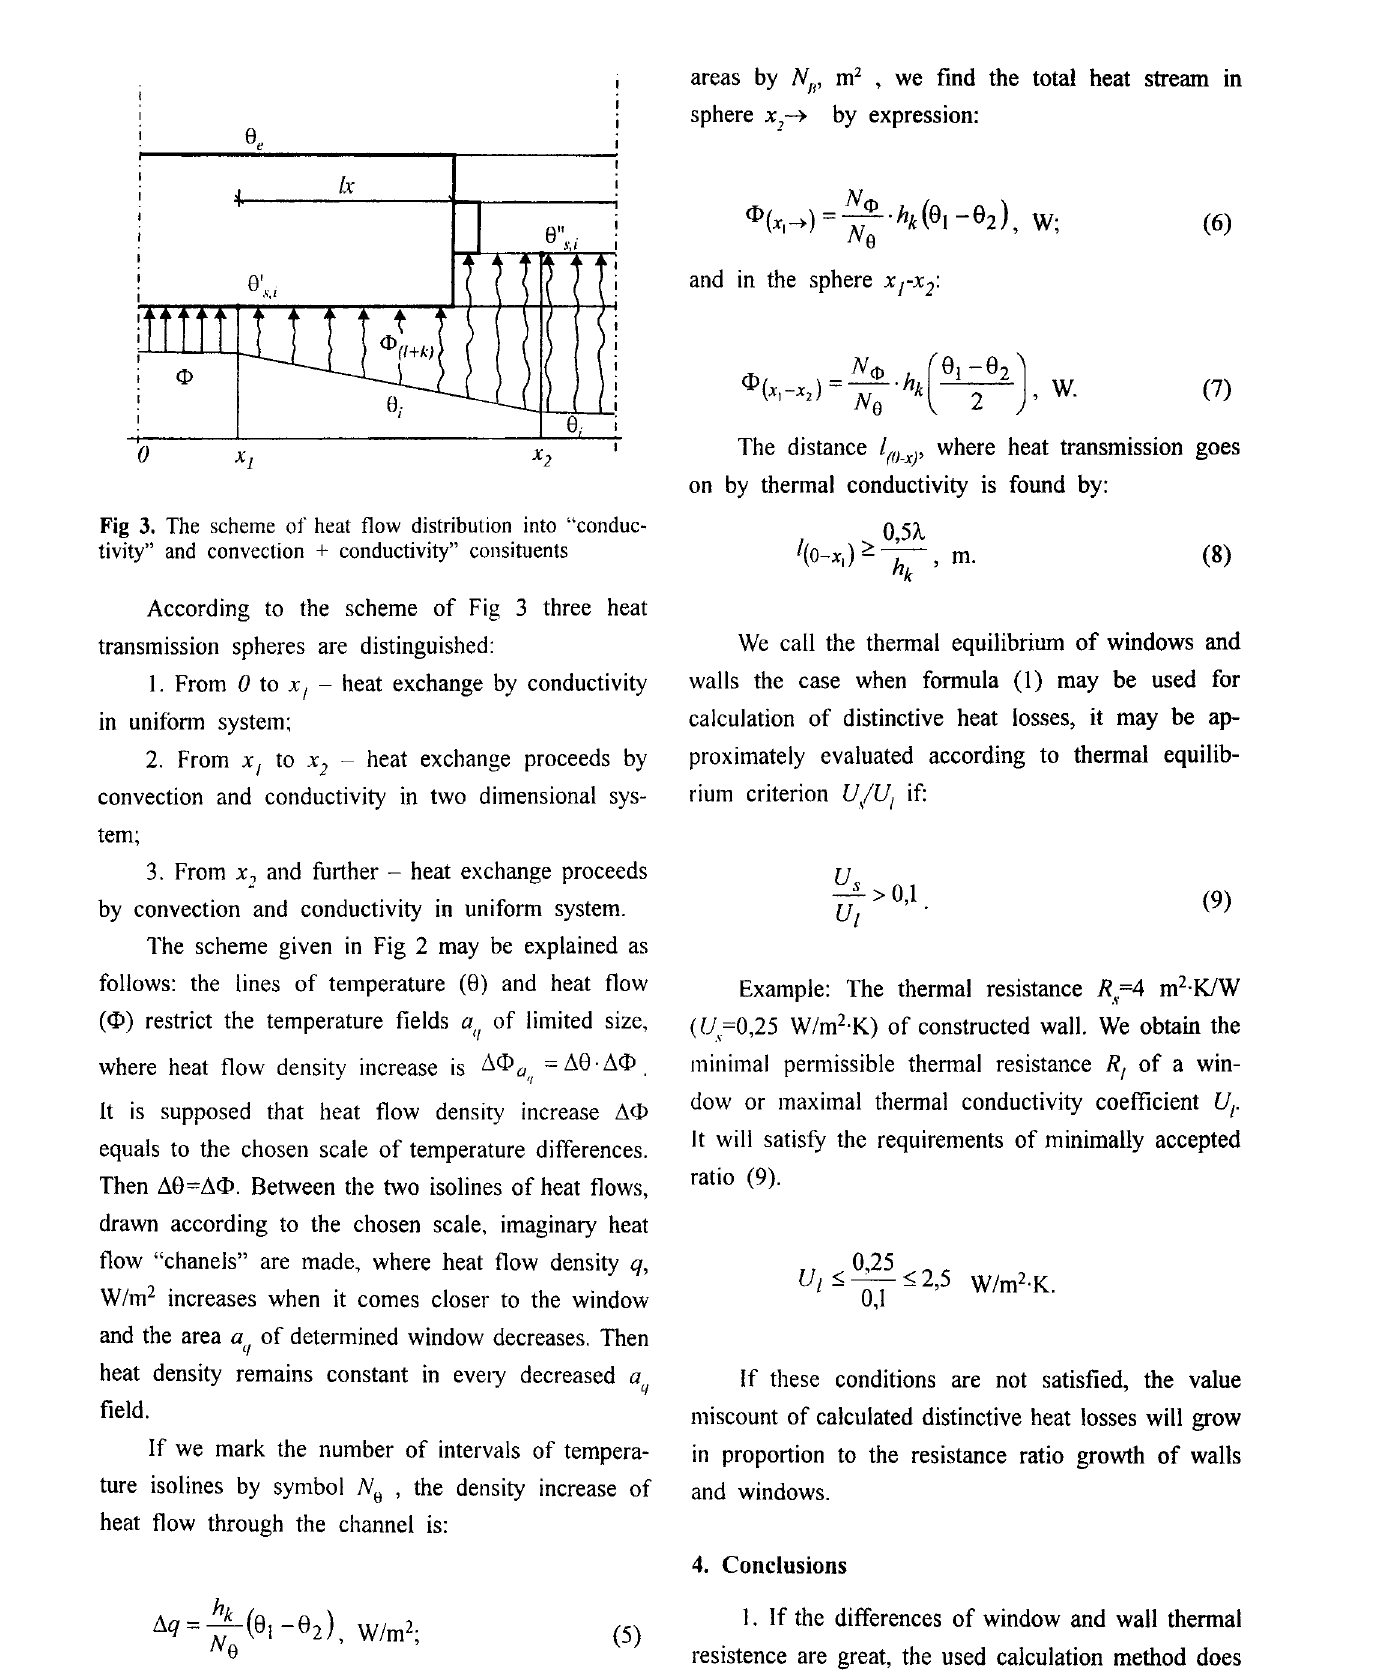
Fig 3. The scheme of heat flow distribution into